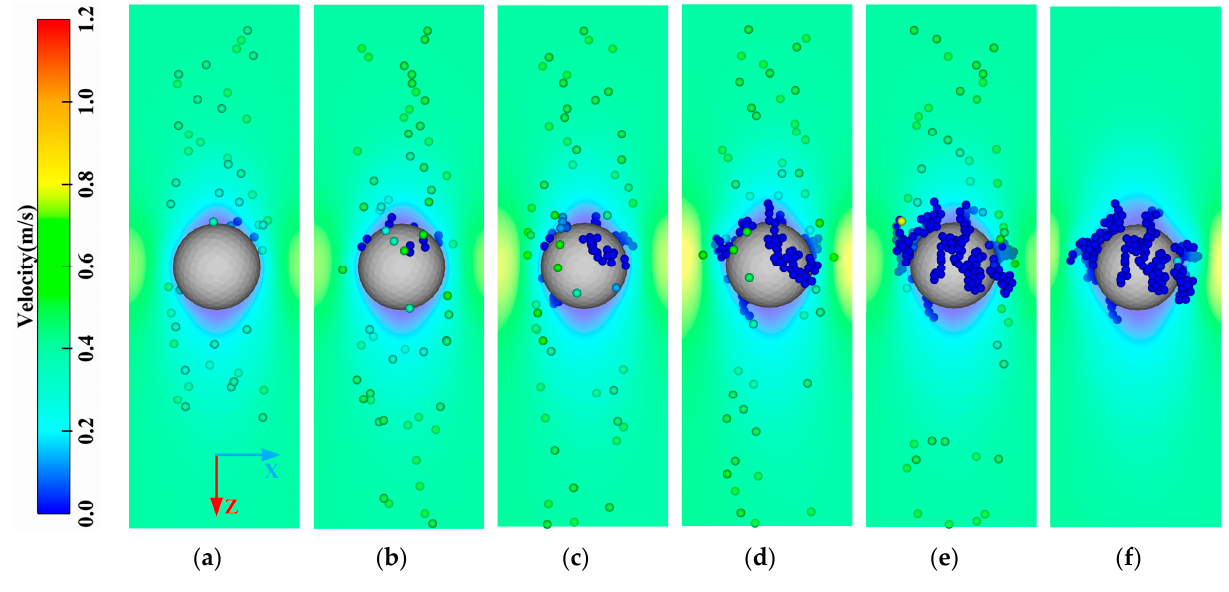
Figure 4. Change in the deposition morphology of the lignin particles with time. ( a ) A (T = 0.1 ms);